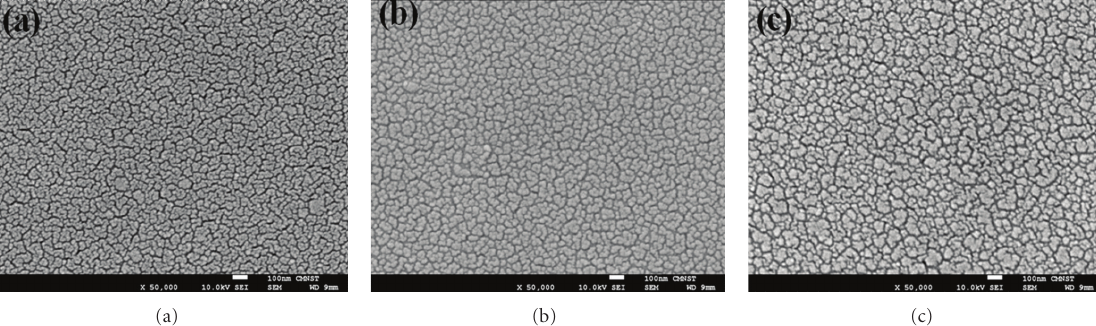
Figure 5: AFM surface views of the ITO thin films treated (a) without annealing and with annealing at (b) 400 ◦ C and (c) 600 ◦ C in 3% H 2 /97% N 2 mixtures atmosphere.